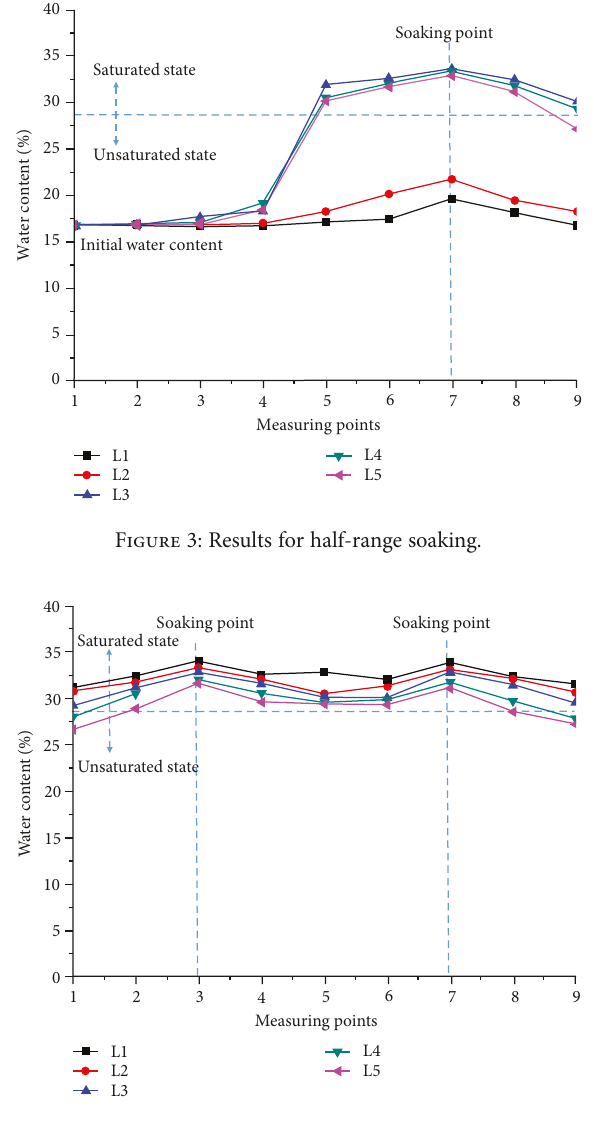
Figure 4: Results for full-range soaking.